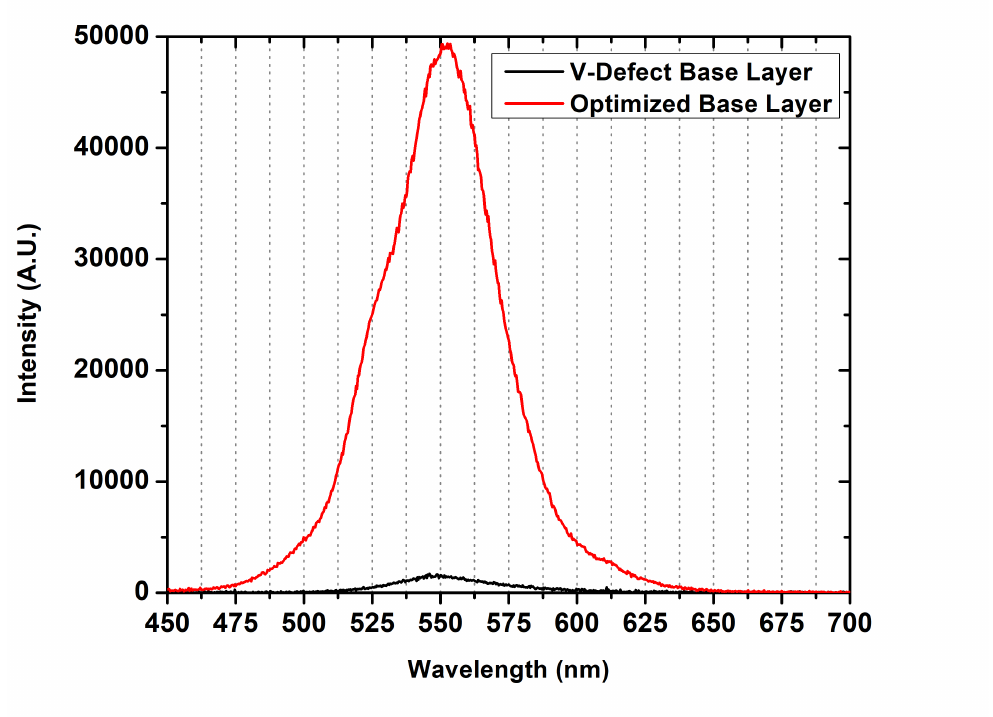
Figure 4. Electroluminescence spectra generated from two devices of nearly identical wavelength, one on a V-defect base layer and the other on an optimized base layer. Equal size devices were used (80 × 80 µ m 2 ) at equal current density injection of 35 A/cm 2 for equivalent comparison. Intensity increases by approximately a factor of